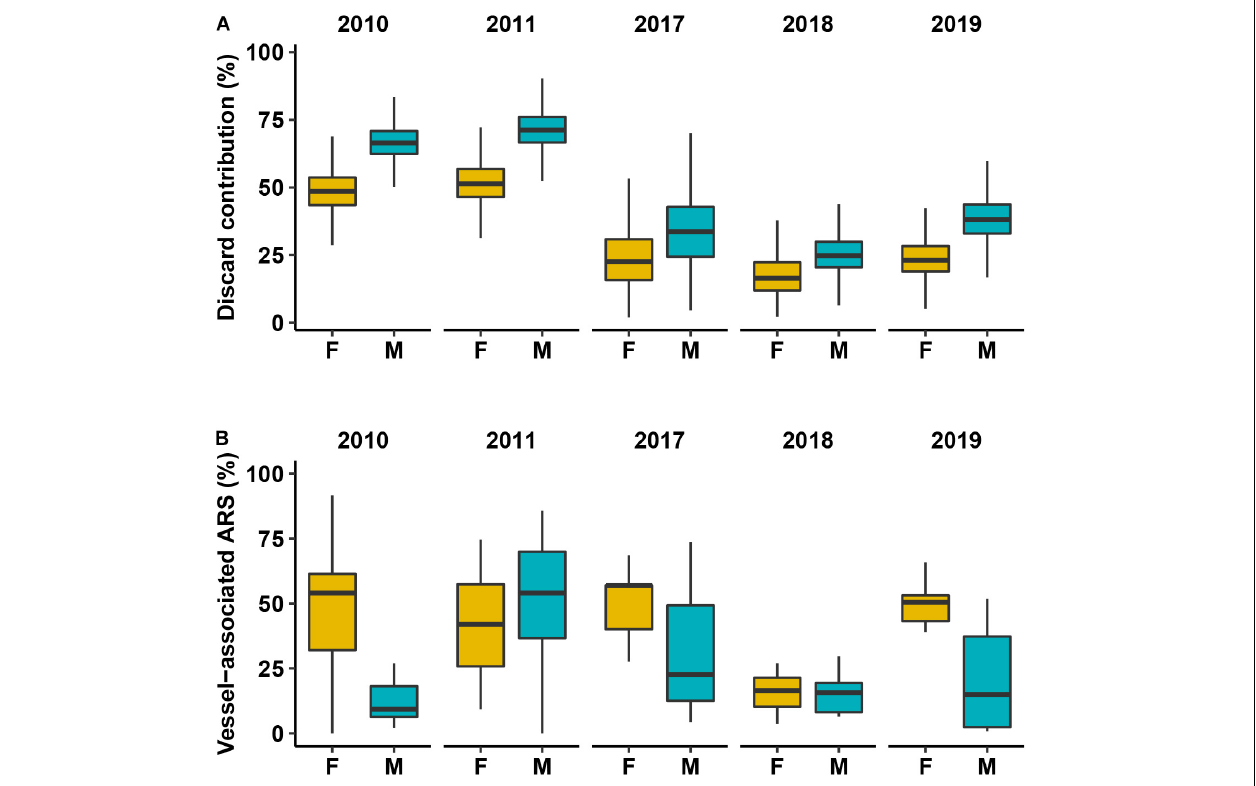
FIGURE 3 | (A) Discard contribution to the diet of northern gannets in Saltee Island and (B) vessel-associated area-restricted search (ARS). Orange, females; blue, males. Black horizontal line depicts the median